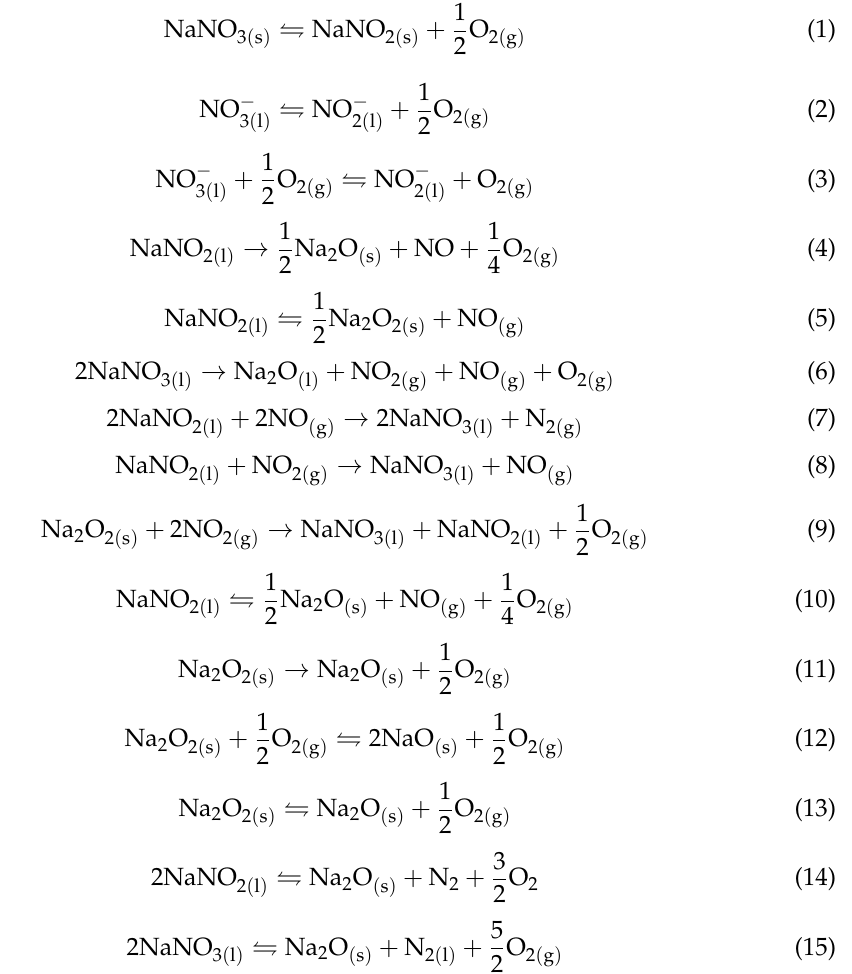
Figure 9 shows the TGA peak deconvolution and the cumulative fit peak (grey dotted line) for pure NaNO 3 (Figure 9a), for SiO 2 NF (Figure 9b) and AlO 3 NF (Figure 9c). All the Gaussian models (cumulative fit peak) show a good fitting (i.e., R 2 = 0.996, 0.998 and 0.999 for pure NaNO 3 , SiO 2 and Al 2 O 3 NFs, respectively); moreover, Table 4 summarizes the parameters of the deconvoluted peaks and also the reactions that contribute to each of